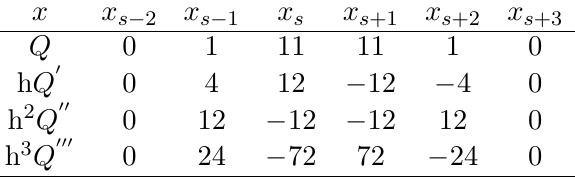
Table 1. Quartic B-splines and their corresponding derivatives at the nodal